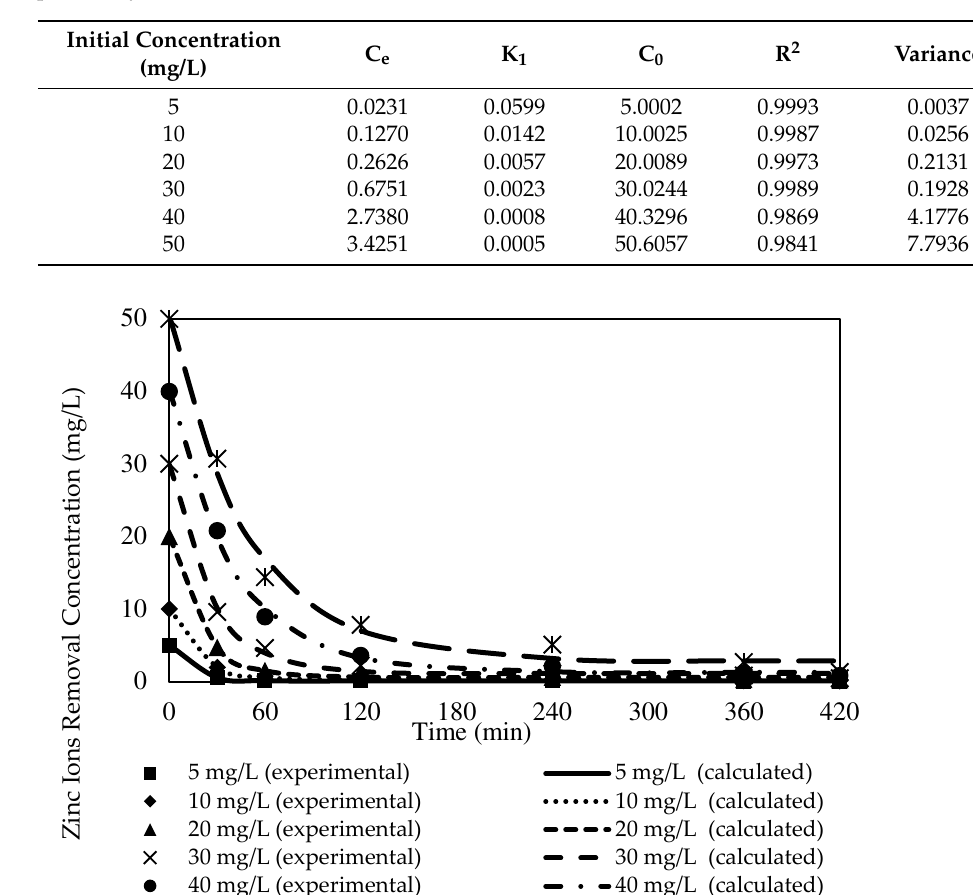
Table 6. Parameter values of the PSO models obtained by numerical calculation for the removal process by the W3 membrane with different initial concentrations.